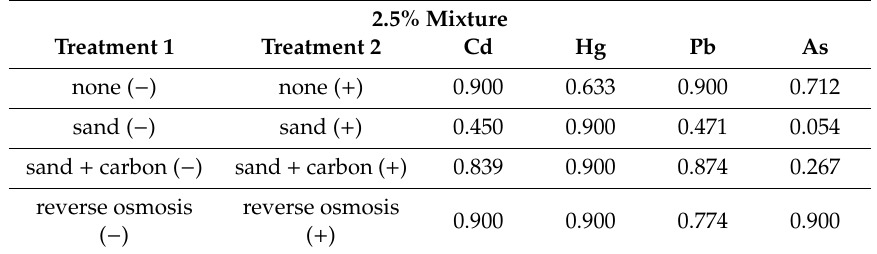
Table 6. Significant di ff erences between each method before ( − ) and after ( + ) nitrification was induced in the PHWW for each metal were calculated using the Tukey HSD method, and the p -values are presented for each treatment comparison. Significant di ff erences ( p < 0.05) are highlighted in red for